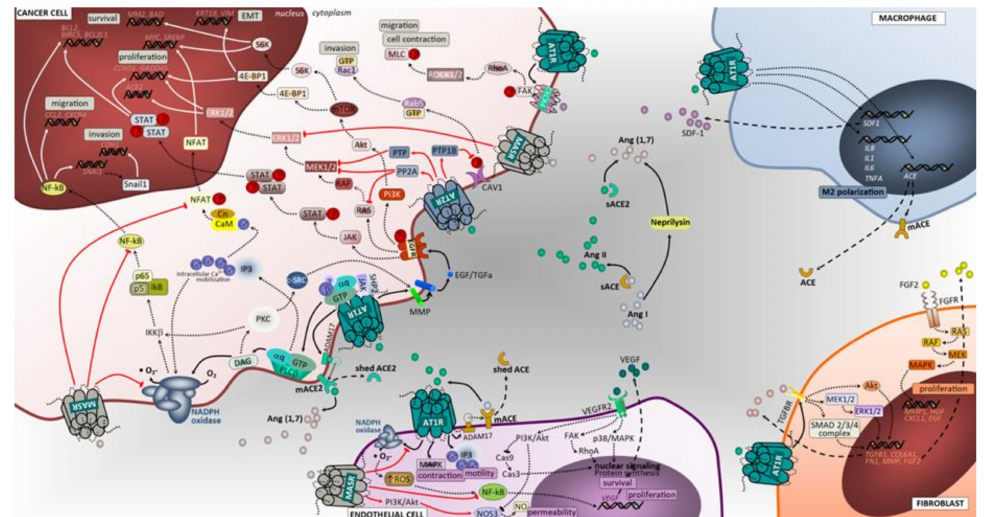
Figure 2. Angiotensin-associated pathways associated with cell proliferation, invasion, and migration in lung tumor microenvironment. Membrane-bound and soluble ACE and ACE2 catalyze the production of angiotensin II or angiotensin (1,7), ligands that exert regulatory functions in tumor microenvironment cells. The e ff ects of activating Ang II / AT1R, Ang II / AT2R and Ang (1,7) / MasR axes’ signaling has been mostly studied in tumor cells, including lung cancer cells. Overall, in contrast to the Ang II / AT1R that mediates several pathological events associated with activated RAS, the Ang (1,7) / MasR and Ang II / AT2R pathways are thought to antagonize many of the cellular actions of the Ang II-AT1R axis. In cancer cells, upon binding of Ang II to AT1R, a pleiotropic downstream signaling cascade is triggered, ultimately causing, either directly or indirectly, upregulation of cell proliferation, survival, motility, migration, invasion and EMT. Activated AT1R subunits stimulate PLC β , that hydrolyses membrane lipids, activates PKC and mobilization of intracellular Ca 2 + , while free G β and G γ subunits bind and gate ion channels. Activated G α q / 11 units also activate the JAK-SHP2 / STAT pathway and receptor tyrosine kinase (RTK) transactivation. Activation of RTK, depicted in the figure as EGFR, occurs through second messenger’s stimulation of ADAM family and MMPs to cleave its ligands (in the figure EGF and TGF α ) that bind and activate RTK. Alternatively, the AT1R-mediated activation of MMPs can follow a PLC β / DAG / PKC / c-SRC signaling mechanism to elicit increased ligands for RTK. Subsequent signaling upon activation of EGFR is represented in the figure using dashed arrows. Other intracellular cascades mediated by Ang II / AT1R include the activation of CXCR4 / SDF-1 signaling through FAK / RhoA / ROCK1-2 / MLC increasing cell contraction, migratory potential and tumor invasion. The Ang (1,7) / MasR activation inhibits NFAT transcriptional regulation that reduces proliferation. Notably, this pathway blocks the NF-kB molecule formation thereby impacting EMT (including Snail1-mediated), invasion and survival. In addition, the inhibitory e ff ect over ERK1 / 2 and NAPH oxidase signaling pathways significantly impact cell proliferation. The Ang II / AT2R pathway signals are mediated through protein phosphatases PTP1B, PTP and PP2A. The inhibition of CAV-1 phosphorylation stops the Rab5 / Rac1 / GTP migratory potential of malignant cells, thus suppressing invasion. Furthermore, AT2R-associated increase in PTP and PP2A exerts blocking e ff ects in RTK-mediated signals of the RAS / RAF / MEK1-2 / ERK1-2 pathway at the level of MERK1 / 2 and RAS molecules, reducing cell proliferation. Macrophages, endothelial cells and fibroblasts are important components of the tumor microenvironment and capable of generating and expressing RAS components. These cells, beyond their functional ligands and receptors that are altered in tumor microenvironment, and reflect the crosstalk between all cell constituents, also use the RAS signaling pathway (mostly AT1R, but also MasR in endothelial cells) to yield functional characteristics that ultimately may favor the cell itself and enhance tumor growth. BIRC5, surviving gene; BCL2, B-cell leukemia / lymphoma 2; BAD, BCL2 associated agonist of cell death; GADD45, Growth Arrest and DNA Damage 45; SREBP, Sterol regulatory element binding proteins; ROCK1 / 2, Rho-associated